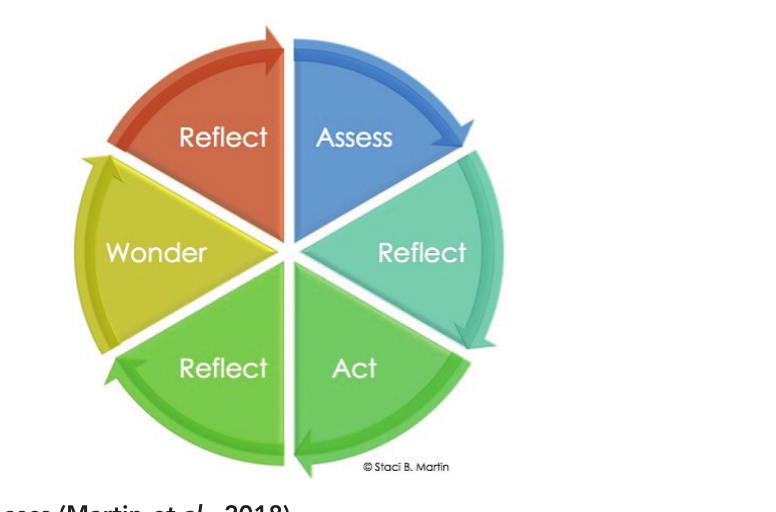
Figure 2. CBA process (Martin et al. ,